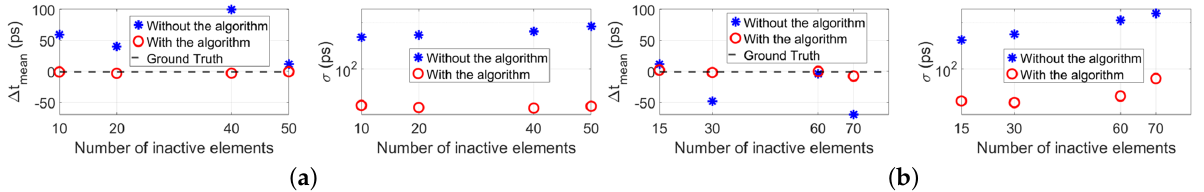
Figure 7. Mean and standard deviation of the transit time difference obtained when considering groups of inactive elements located ( a ) at the center of the aperture of the arrays, and ( b ) at the center and both edges of the aperture of the arrays (i.e., 1/3 of the total number of inactive elements at each location). Per number of inactive elements, a data point of ∆ t mean represents the mean of 50 “virtual” transit time differences values obtained from 50 simulated noisy wavefields, and a data point of σ represents the standard deviation of those 50 “virtual” transit time differences values. The dashed black line on the graphs for ∆ t mean represents the value obtained without inactive elements, i.e., ∆ t mean = −